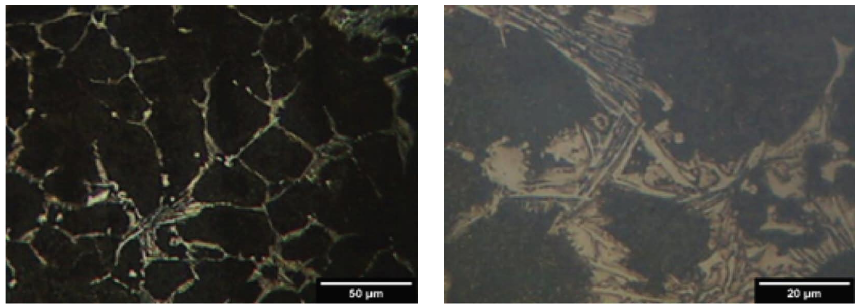
Figure 7: Microstructure of 2V-13W-HC steel in the as-cast